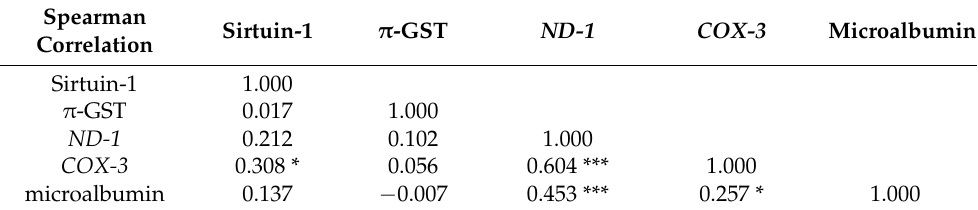
Figure 3. Comparison of urinary biomarkers ( A ) sirtuin-1, ( B ) π -glutathione S-transferase ( π -GST), ( C ) NADH-ubiquinone oxidoreductase chain 1 ( ND-1 ), and ( D ) cytochrome c oxidase subunit III ( COX-3 ) between pre- and post-work task sample of farmers who sprayed single or cocktail use of herbicide. The data represented as median and 95% confidence interval. ng: nanogram; mg: milligram; Cr: creatinine; Ct: threshold cycle. Table 3. Spearman correlation of all urinary